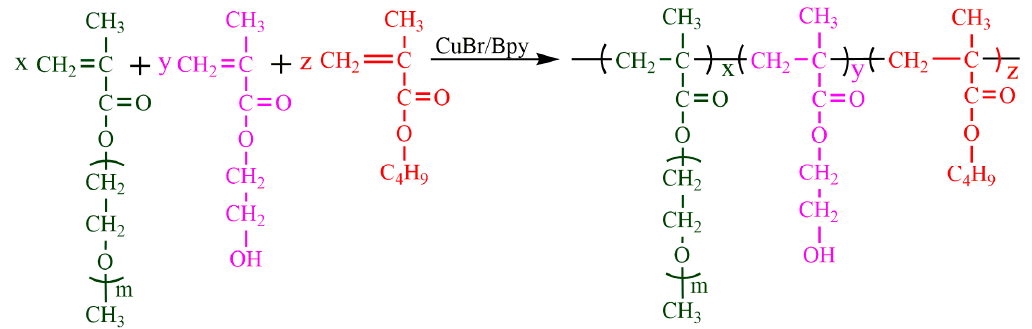
Figure 1. The structure of copolymer P(OEGMA-co-HEMA-co-BMA) .